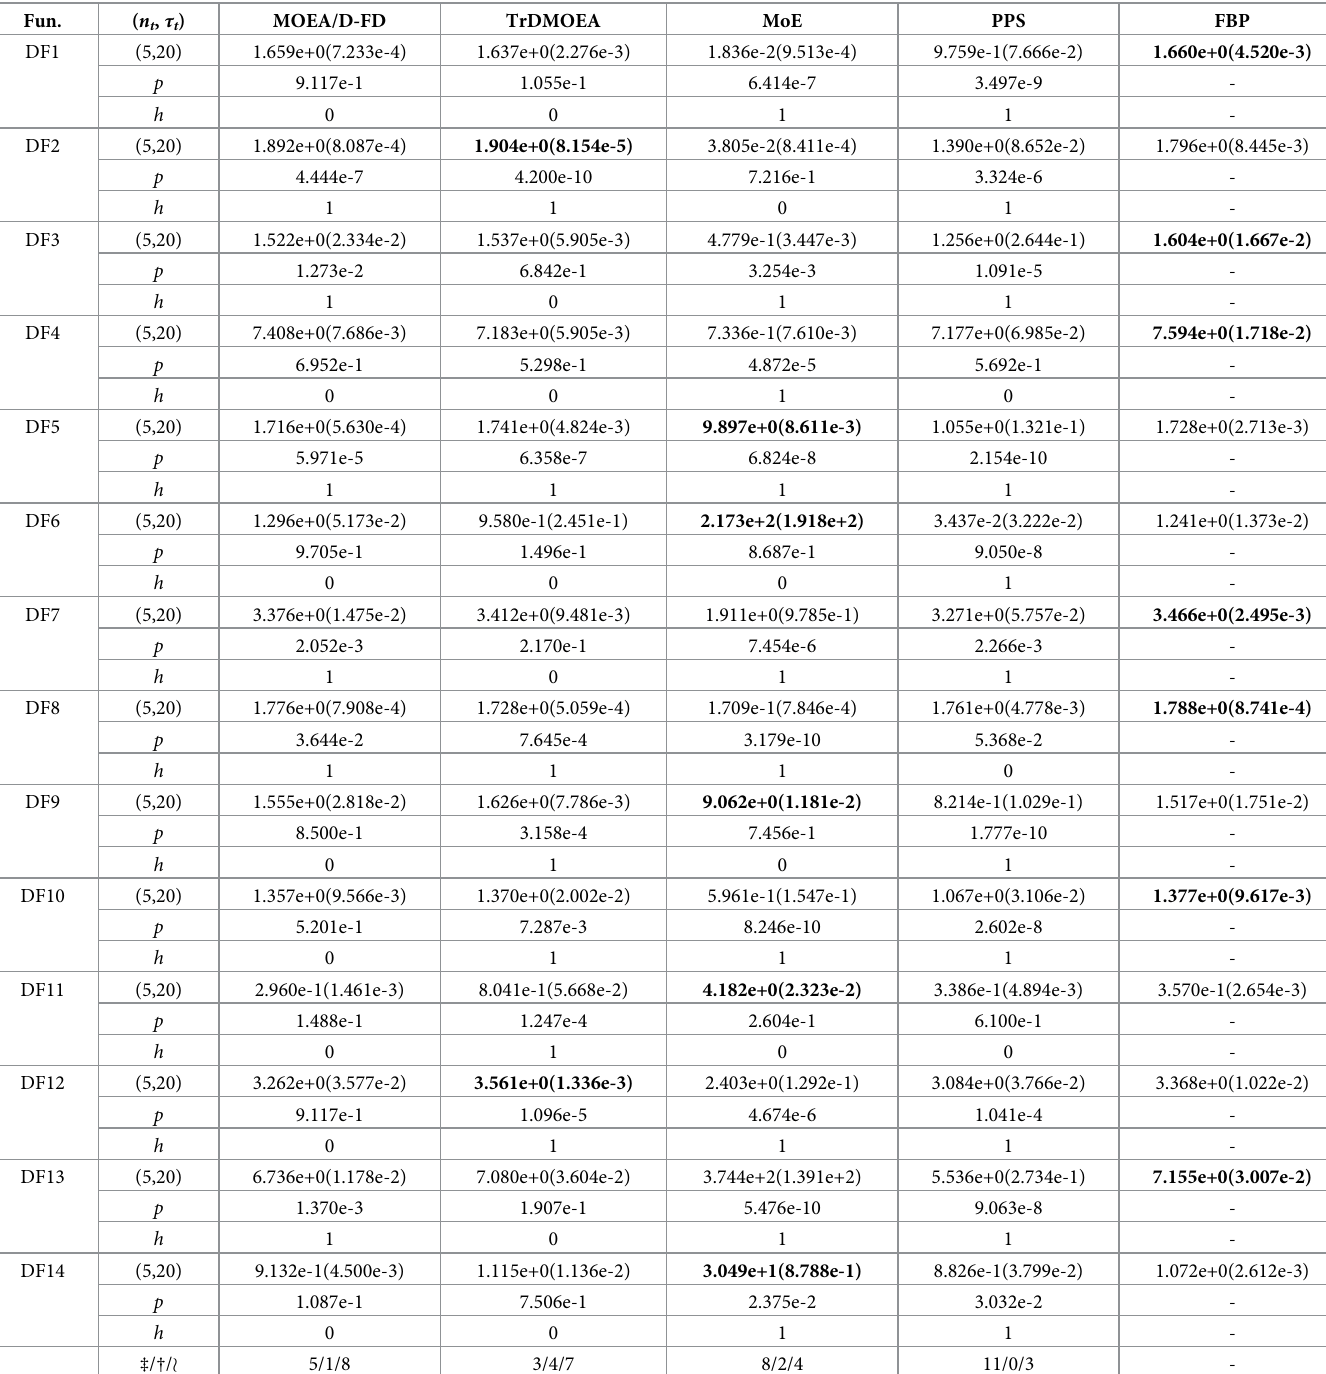
Table 4. Mean and standard deviation values of MHV obtained by five algorithms for ( n t , τ t ) = (5,20).